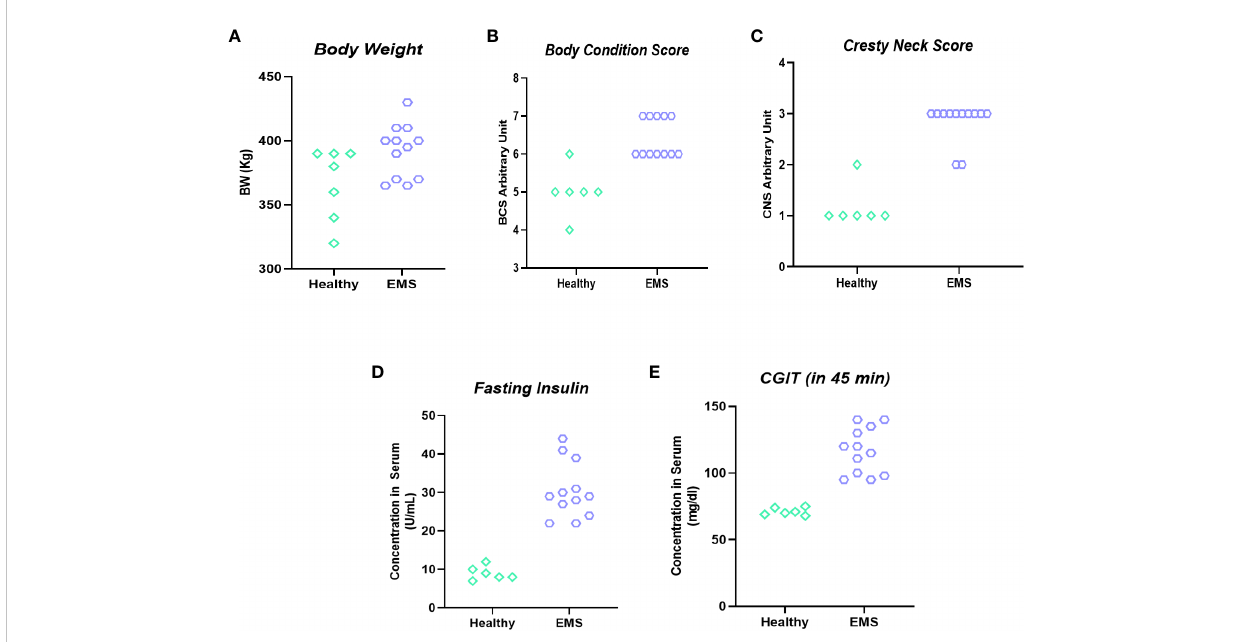
FIGURE 6 Clinical parameters used for horses ’ enrolment into “ experimental EMS ” and “ control ” group. Individual data representation of body weight (A) , body score condition (B) , cresty neck score (C) , fasting insulin (D) and CGIT (E) .